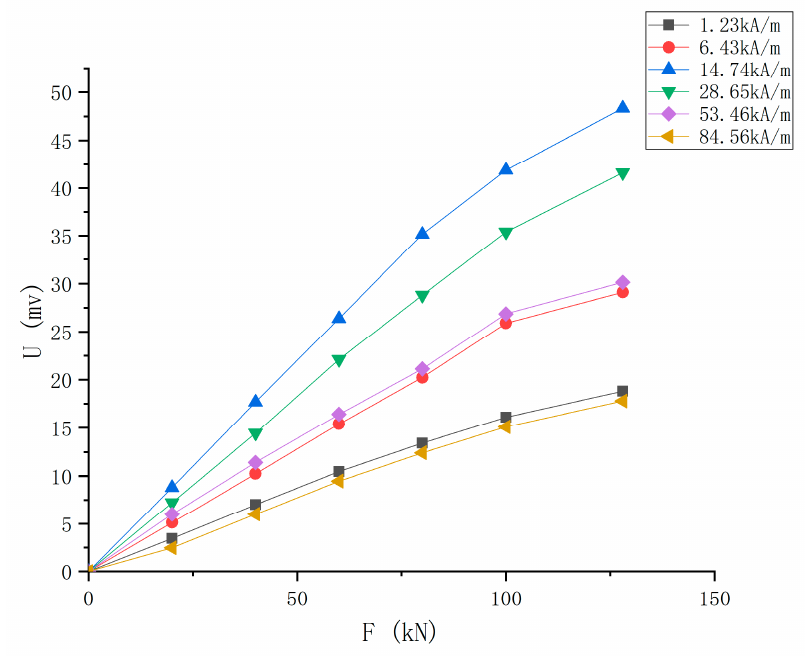
Figure 15. Relationship between sensor output voltage and force under different bias magnetic fields.